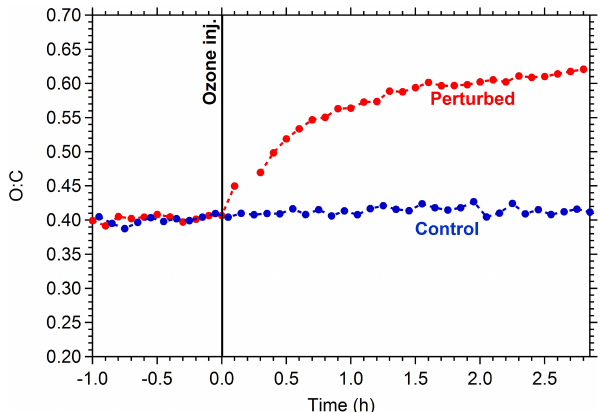
Figure 3. Oxygen-to-carbon ratio of the OA in the perturbed (red line) and the control chamber (blue line) during Exp.